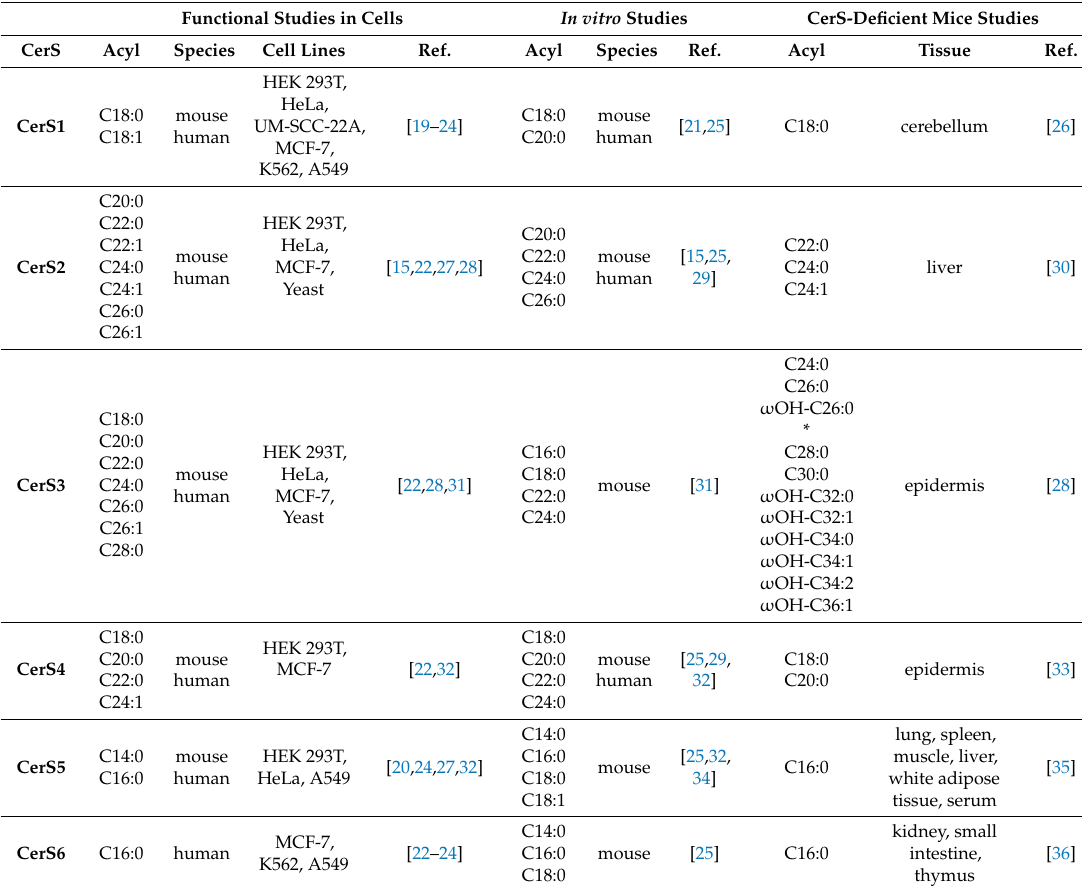
Table 1. Ceramide synthases acyl-chain specificity. Ceramide synthases (CerS) acyl-CoA preferences for the synthesis of ceramides according to di ff erent experimental approaches. Functional Studies in Cells In vitro Studies CerS-Deficient Mice Studies